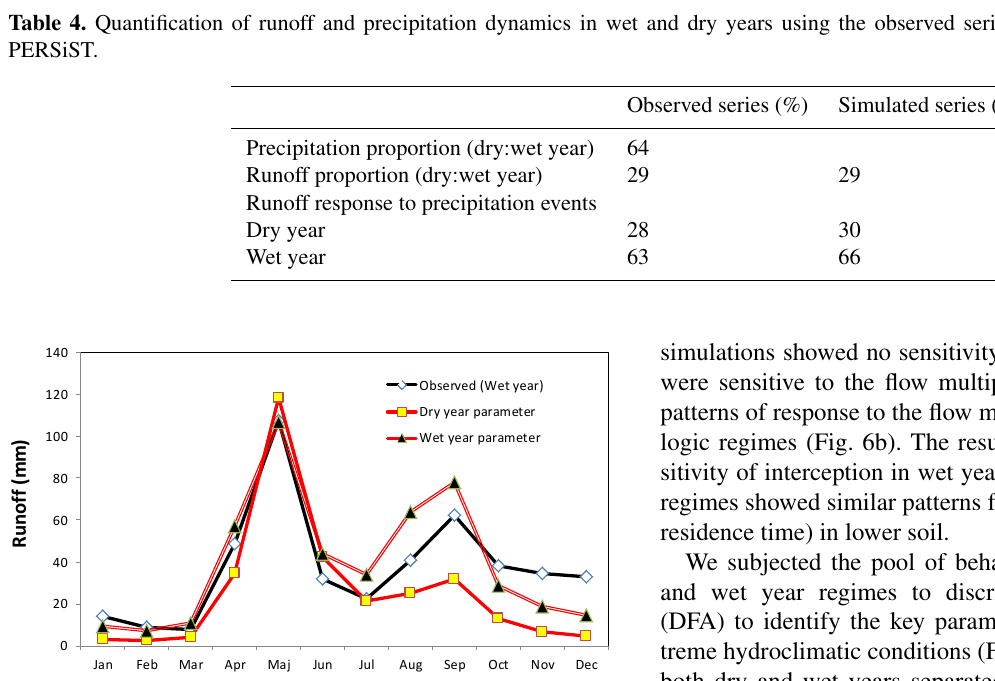
Figure 4. Quantification of predictive uncertainty in runoff simula- tions when the best parameter set (based on NS) calibrated for dry years was used for wet year observed